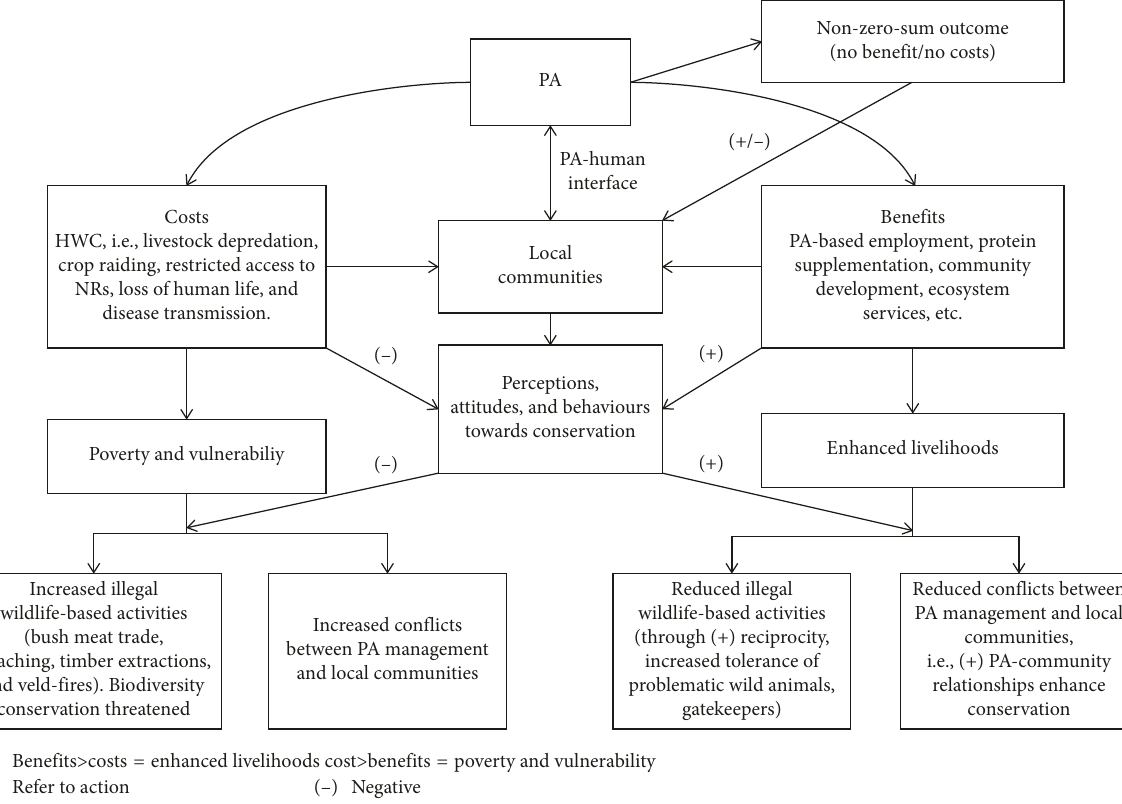
Figure 1: Conceptual framework denoting reciprocity in PA-local community interface based on the social exchange theory (SET). PA, protected